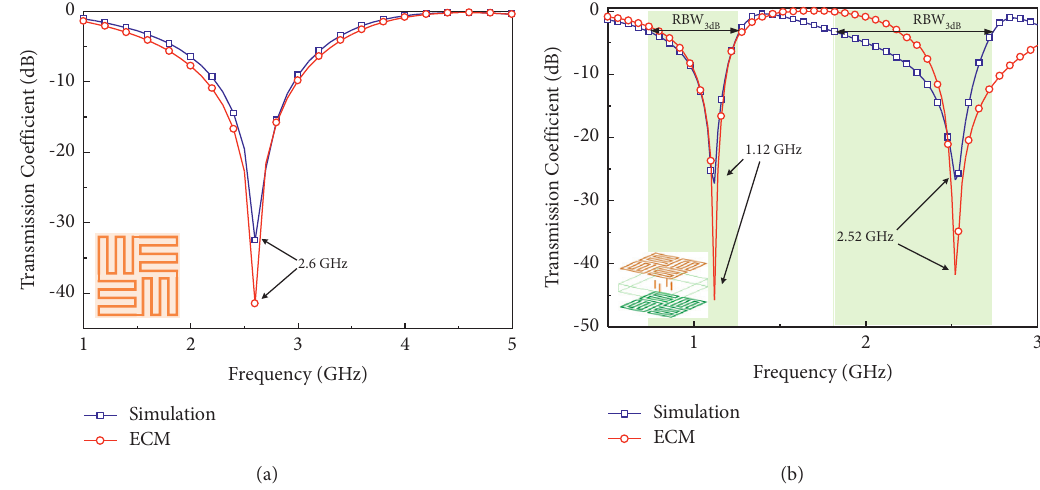
Figure 4: Transmission coefficient of the ECM and simulation results: (a) the single-layer FSS; (b) the double-layer FSS.